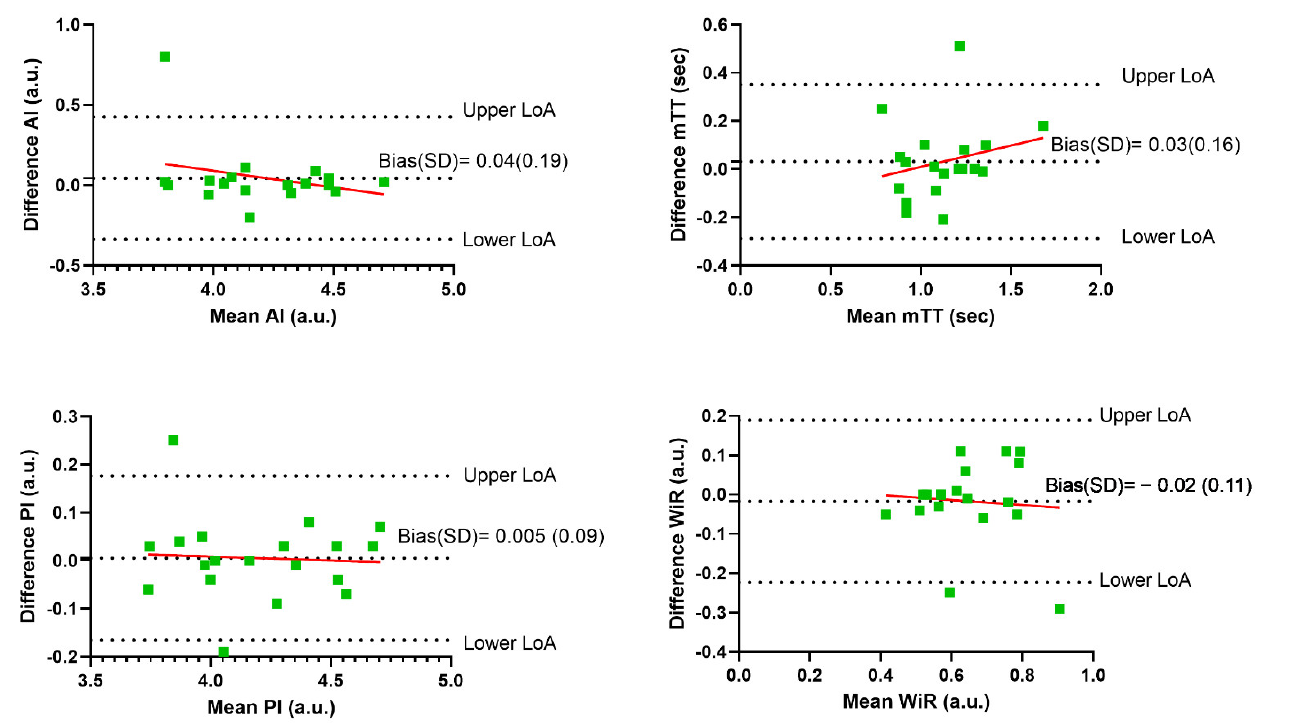
Figure 3. Inter-observer variability Bland–Altman plots; with linear regression line (red). LoA = 95% limit of agreement.